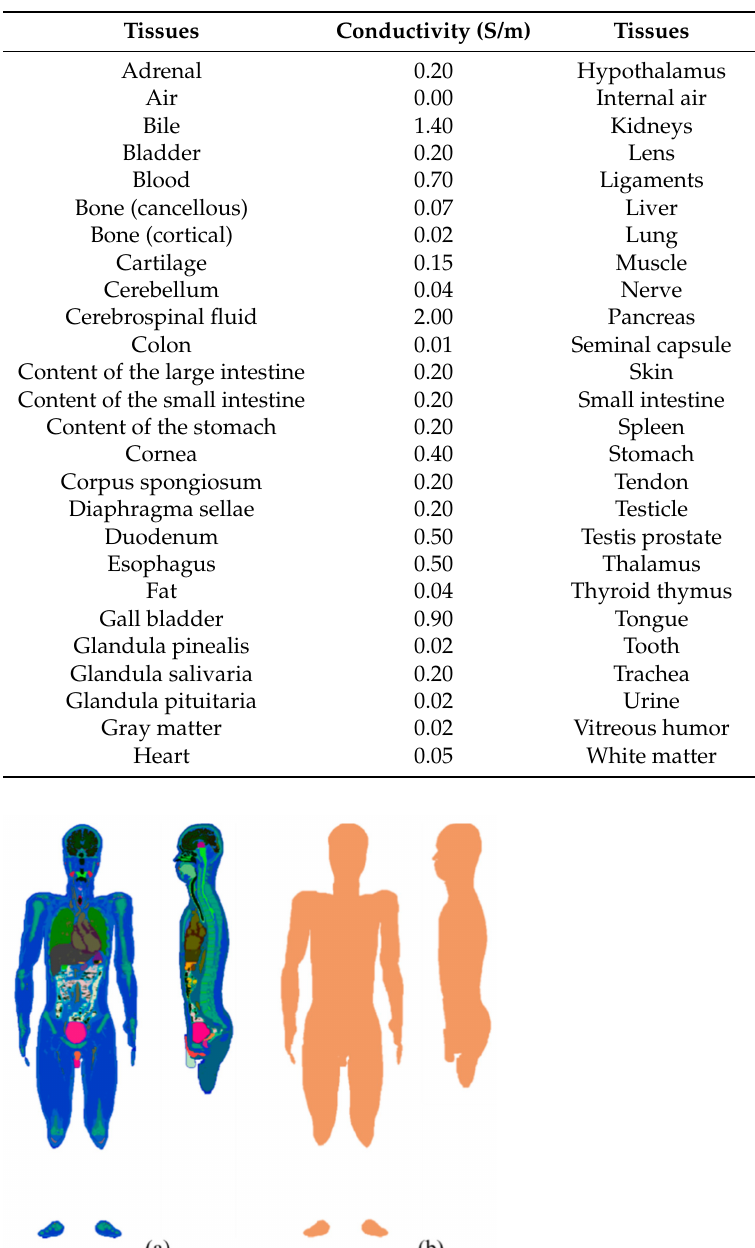
Table 1. Conductivity of human tissues.